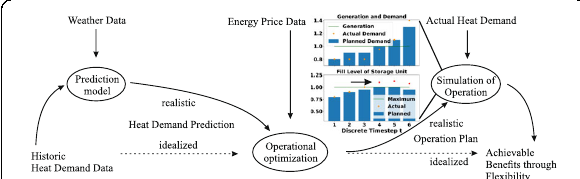
Fig. 1 (abstract PW4). Methodology depicted in comparison with an idealized evaluation of operational optimization. Simulation of operation will reveal prediction error induced complications indicated with red dots and highlighted by an arrow. Scope of this work is to analyse whether reacting on occurrence or avoiding conflicting situations beforehand has a smaller impact on